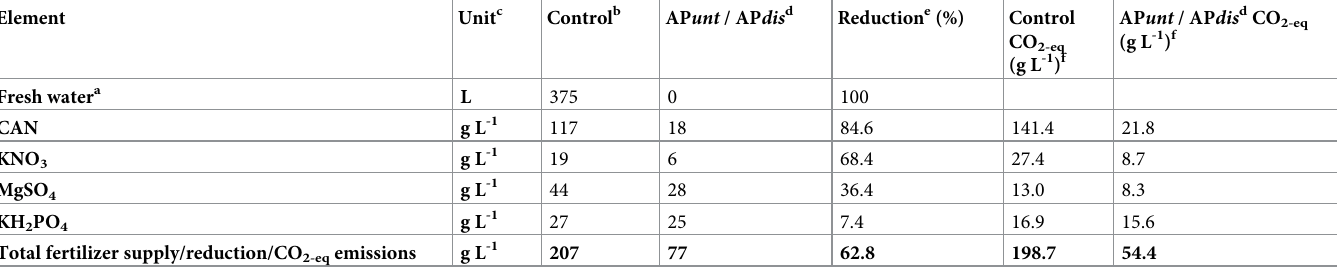
Table 3. Resource utilization (minerals, water) of butterhead lettuce grown in nutrient solution formulated with fresh water (control: 50:50, v/v fresh and rain water), fish water (AP unt ) and disinfected fish water (AP dis ). Element Unit